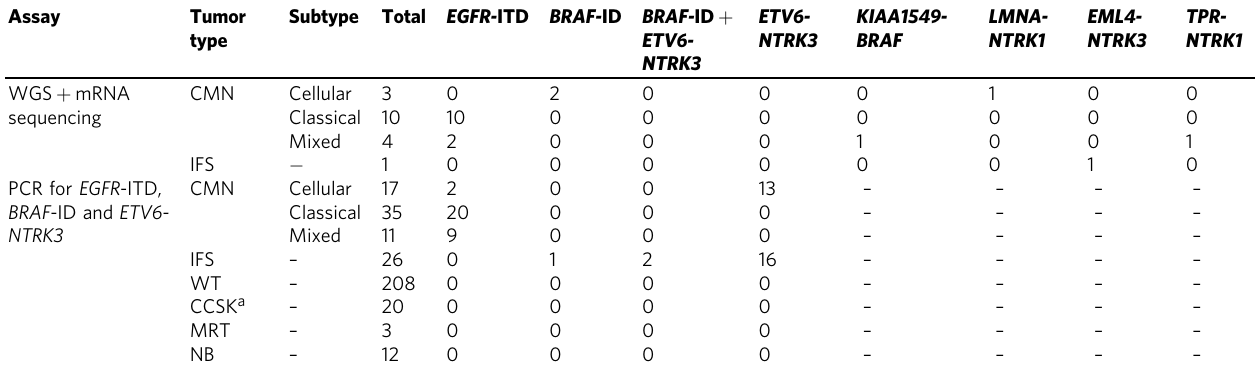
Table 1 Rearrangements in infant soft tissue tumors Assay Tumor